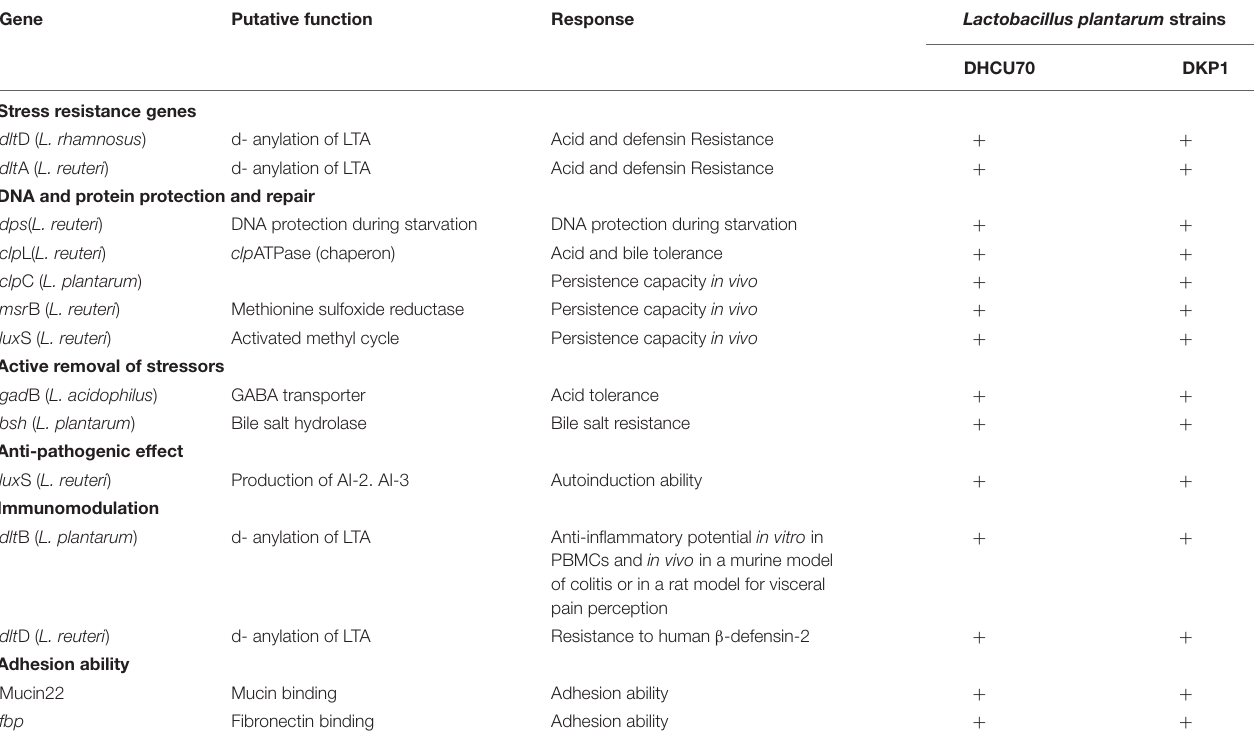
Stress resistance